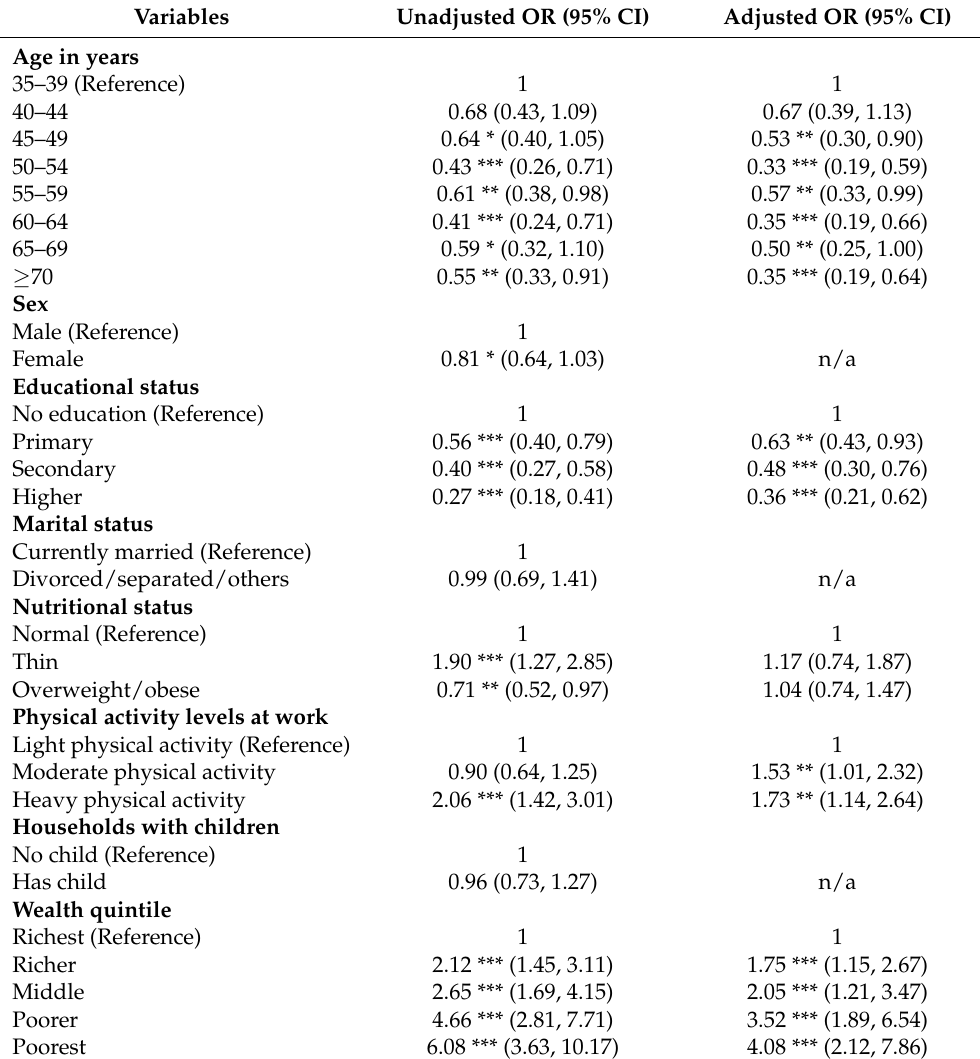
Table 3. Cluster controlled determinants of undiagnosed diabetes among adult diabetic patients in